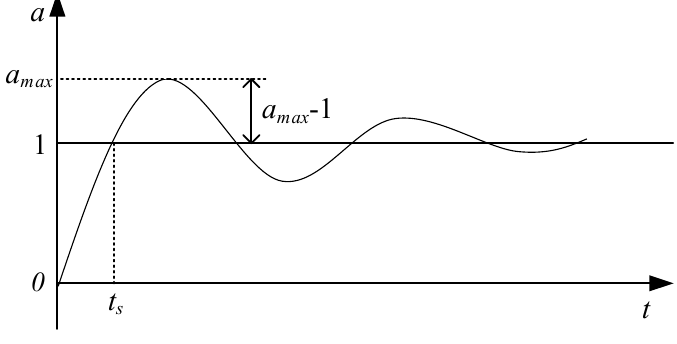
Figure 12. The rotational speed speed curves of PSU.